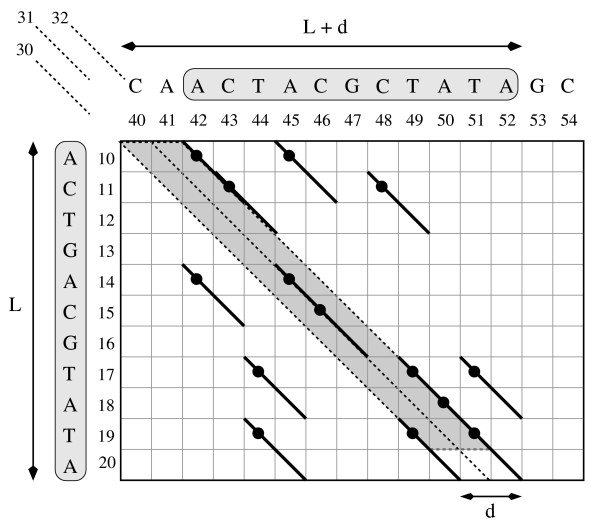
A (L, d, 2)-repeat and a parallelogram. An example a (L, d, 2)-repeat with L = 11, d = 2. Diagonals 30, 31, and 32 are shown. Among them, 30 and 32 have distance 2, while 30 and 31 (as well as 31 and 32) are consecutive. Assuming that q = 2, a q-hit is represented by a thicker diagonal of length 2 plus a small black circle representing its pair of coordinates. The q-hit (19, 49) refers to the q-gram TA, and 19 (resp. 49) is its first (resp. second) projection. The q-hit (17, 49) refers to the same q-gram TA but has a different first projection. The words inside the grey boxes are two distinct fragments of the same sequence s, namely s[10, 20] and s [42, 52]; they have length 11, and their edit distance is 2. We obtain one word from the other by deleting s[13] – hence no q-hits in positions 12, 13 – and by inserting s [48] – no q-hits in positions 47, 48. We have p = 6 and the set S of 7 q-hits in diagonals 31 and 32 satisfies the properties (1), (2), (3), (4) and (5). If we add the q-hit in diagonal 30 in order to obtain a new set S′, properties (1), (2) still hold, but properties (3), (4) and (5) are no longer satisfied.